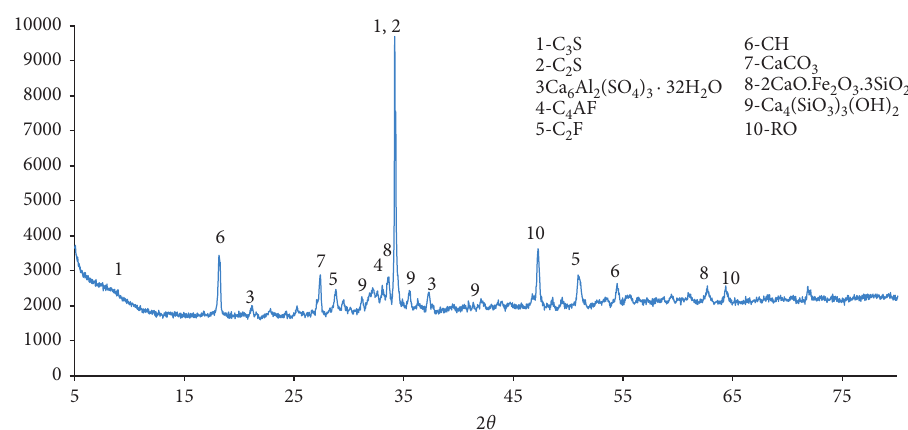
Figure 5: XRD of cement with 20% steel slag, hydrated at 28